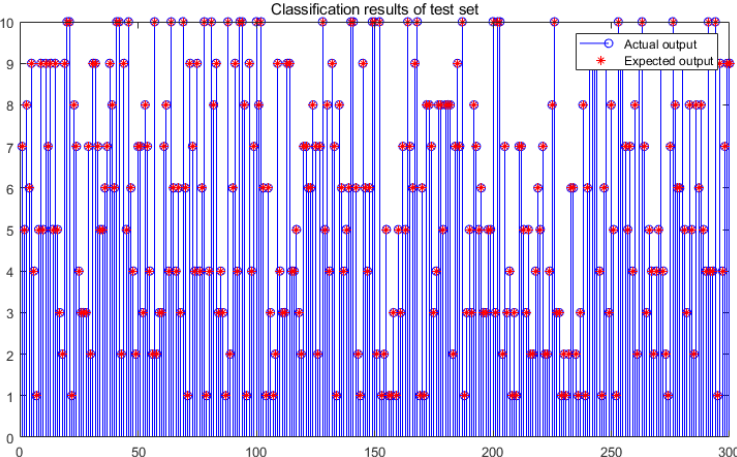
Figure 7. Fault classification result of test set. Table 2. Comparison of our method before and after